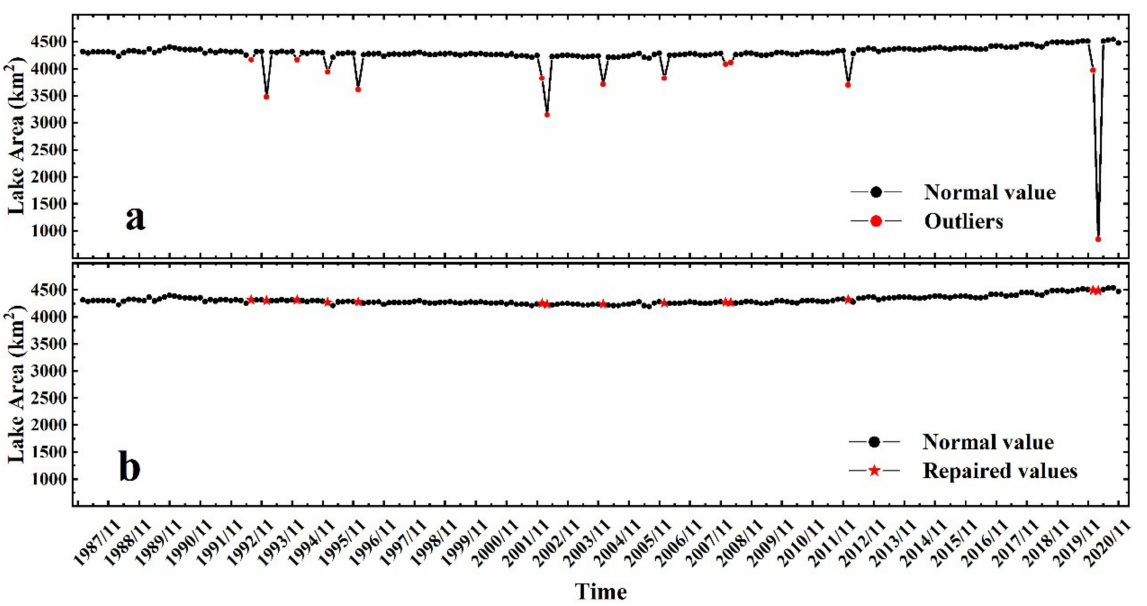
Figure 6. Anomaly detection and reconstruction of Qinghai Lake surface area bimonthly sequence. ( a ) Outlier detection results. ( b ) Sequence repair and reconstruction